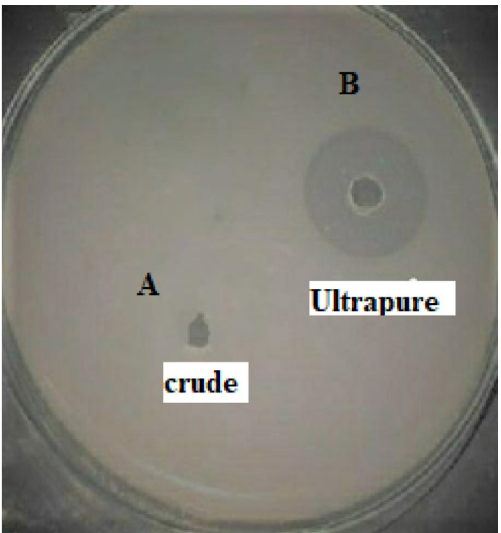
Figure 7. Fibrin plate assay for ( A ) crude fraction from micellar extractive fermentation and ( B ) Ultrapre fraction from anion exchange